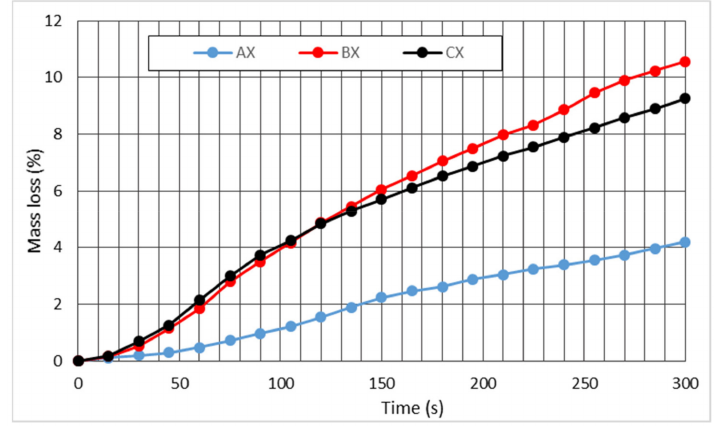
Figure 6. Mutual comparison of the increase in mass loss of eco panels in groups A, B, and C based on time of burning. Note: The value X represents the average value of all samples in each group.